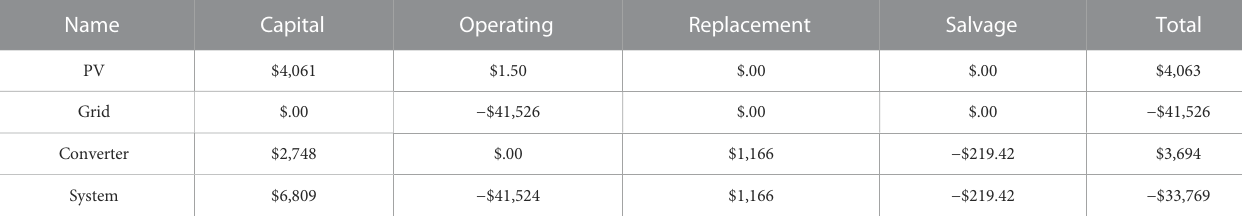
TABLE 5 Annualized cost for the proposed system.